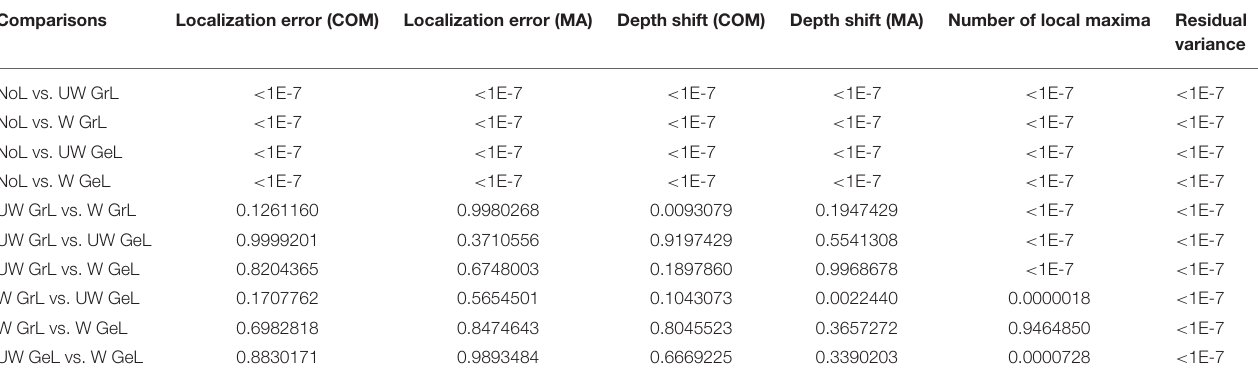
TABLE 5 | Post-hoc p -values for the comparison of all measures using Tukey’s honestly significant difference criterion. All comparisons with p -value < 0.05 are considered significant.